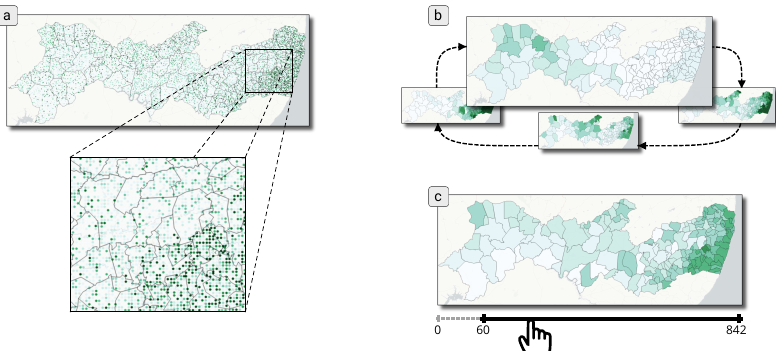
Figure 1. Visual metaphors for the visualization of a probability distribution of geographical data that support probability quantification of analytical tasks tested in this study: ( a ) distribution dot map (DDM) , where dots are randomly positioned inside the regions and are colored according to the sampled value, ( b ) hypothetical outcome maps (HOM) , where a series of maps are created based on the probability distribution, and then animation is used to cycle through them, and ( c ) distribution interaction map (DIM) , where the user can quantify the probability distribution using interactive widgets and